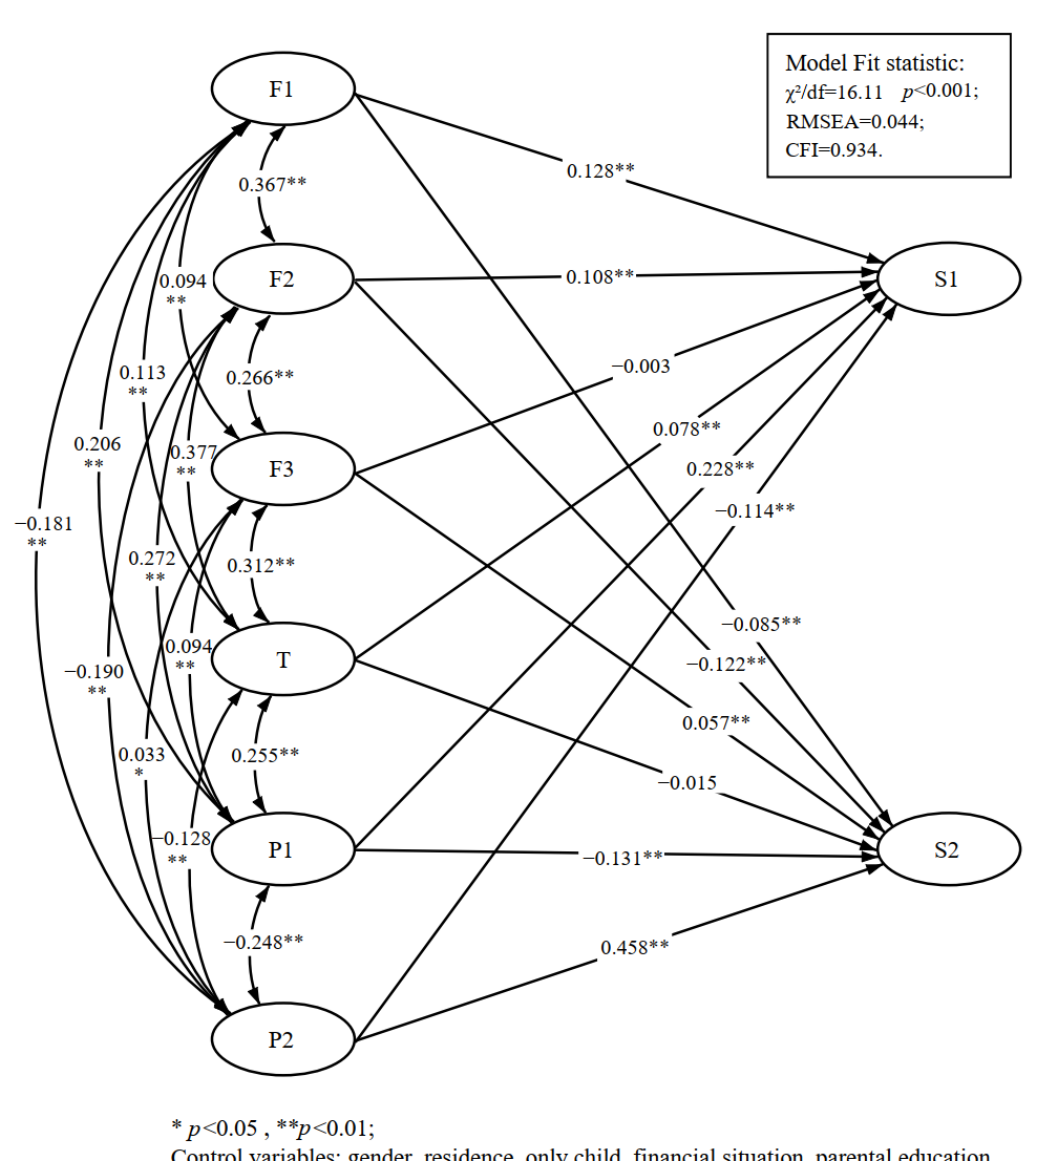
Figure 2. Structural equation model normalization results.